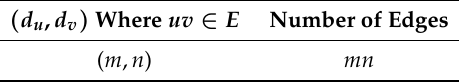
3 ) on the basis of degree sum of neighbors of end vertices of ≥